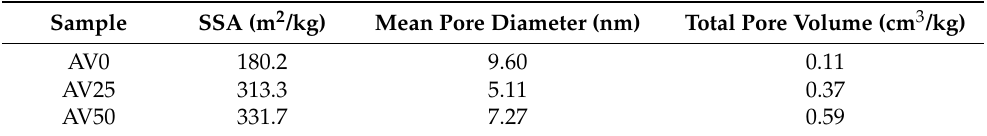
Table 3. BET-BJH data for treated Aloe vera